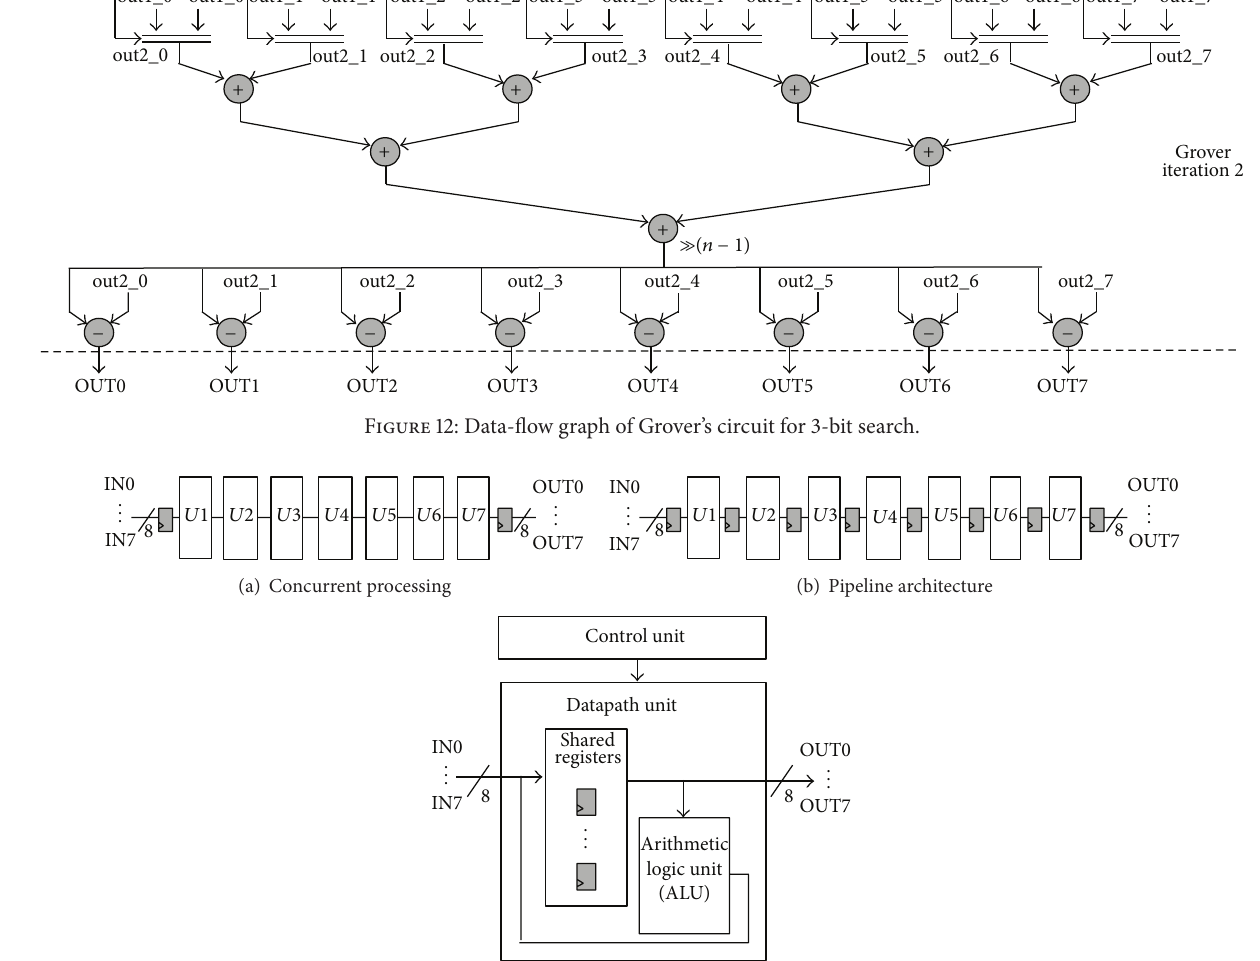
Figure 13: Three-qubit QFT implemented using different hardware